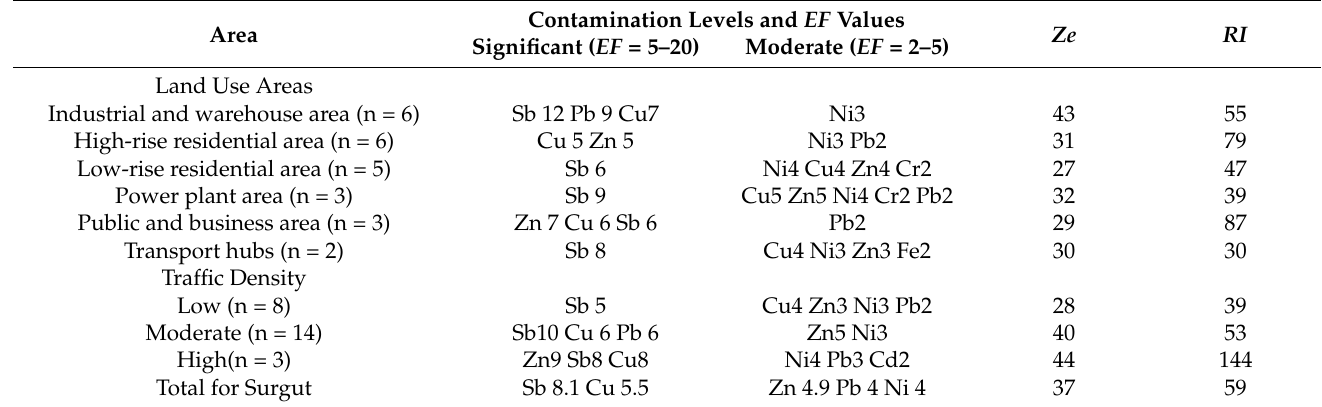
Table 4. The values of enrichment factor ( EF ), total potential ecological risk index ( RI ) and total enrichment factor ( Ze ) in the road dust of